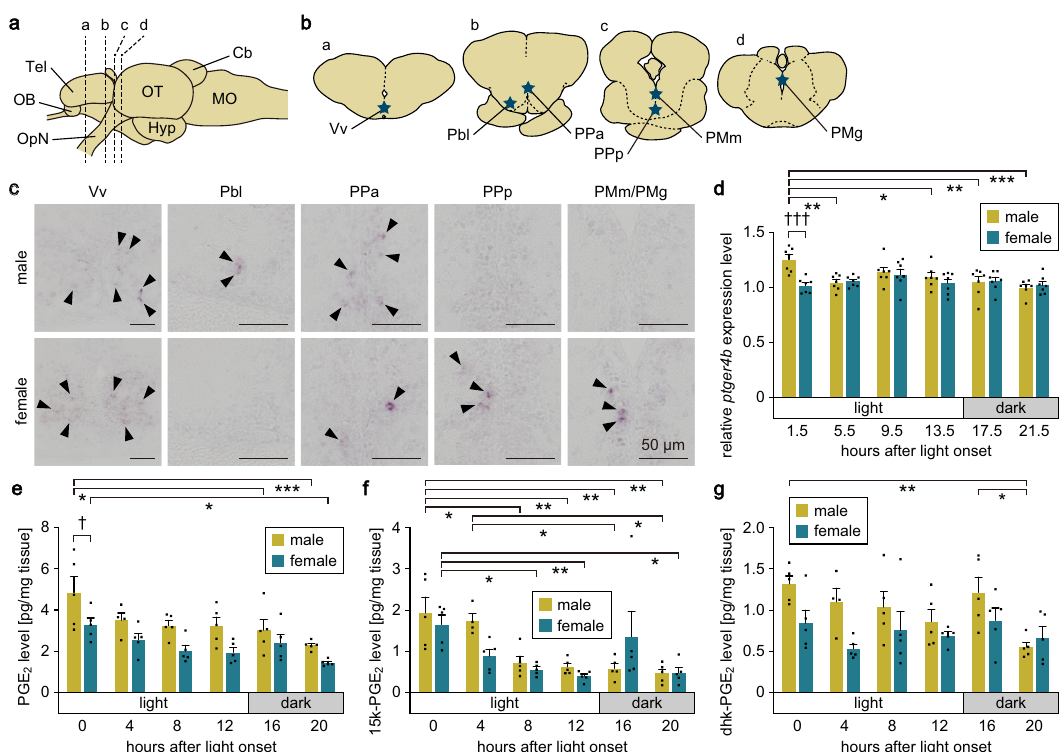
Fig. 3 PGE 2 /Ptger4b signaling in the female brain exhibits diurnal fl uctuation at the ligand level. a Lateral view (anterior to the left) of the medaka brain showing the approximate levels of coronal sections presented in panel ( b ). Cb cerebellum; Hyp hypothalamus; MO medulla oblongata; OB olfactory bulb; OpN optic nerve; OT optic tectum; Tel telencephalon. b Coronal sections depicting the location of the Vv, Pbl, PPa, PPp, and PMm/PMg. c Representative micrographs depicting ptger4b expression in the Vv, Pbl, PPa, PPp, and PMm/PMg of males and females. Arrowheads indicate representative ptger4b - expressing neurons. Scale bars represent 50 μ m. d Diurnal fl uctuations of ptger4b expression in male and female brains as determined by real-time PCR ( n = 7 per sex and time). Mean value of females at 1.5 h after light onset was arbitrarily set to 1. Diurnal fl uctuations of PGE 2 ( e ), 15k-PGE 2 ( f ), and dhk- PGE 2 ( g ) levels in the male and female brains as determined by LC-MS/MS ( n = 5 per sex and time, except males at 4 h after light onset, where n = 4). Quantitative data were expressed as means with error bars representing standard error of the mean. Statistical differences were assessed by Bonferroni ’ s post hoc test ( d – g ). * p < 0.05; ** p < 0.01; *** p < 0.001 (between time points of the same sex). † p < 0.05; ††† p < 0.001 (between sexes at the same time